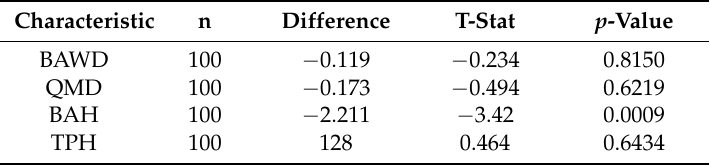
Table 3. NAIP vs LiDAR Paired t-test results for 100 summarized stand level estimates (n) of basal